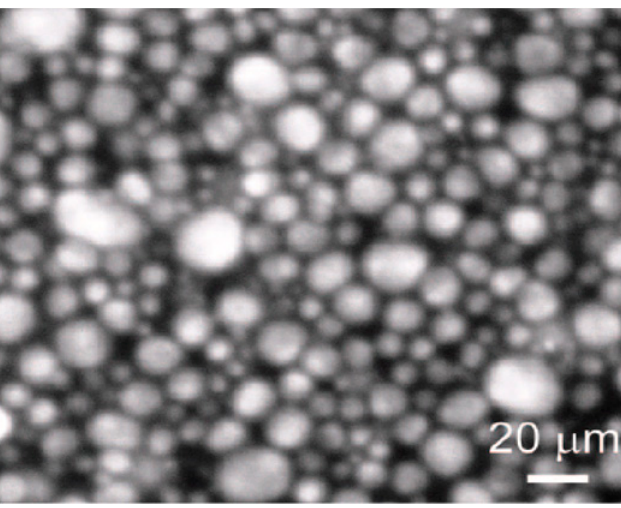
Figure 2. Photo for microstructure of water–oil system stabilized by particles of alum. oxide [13].